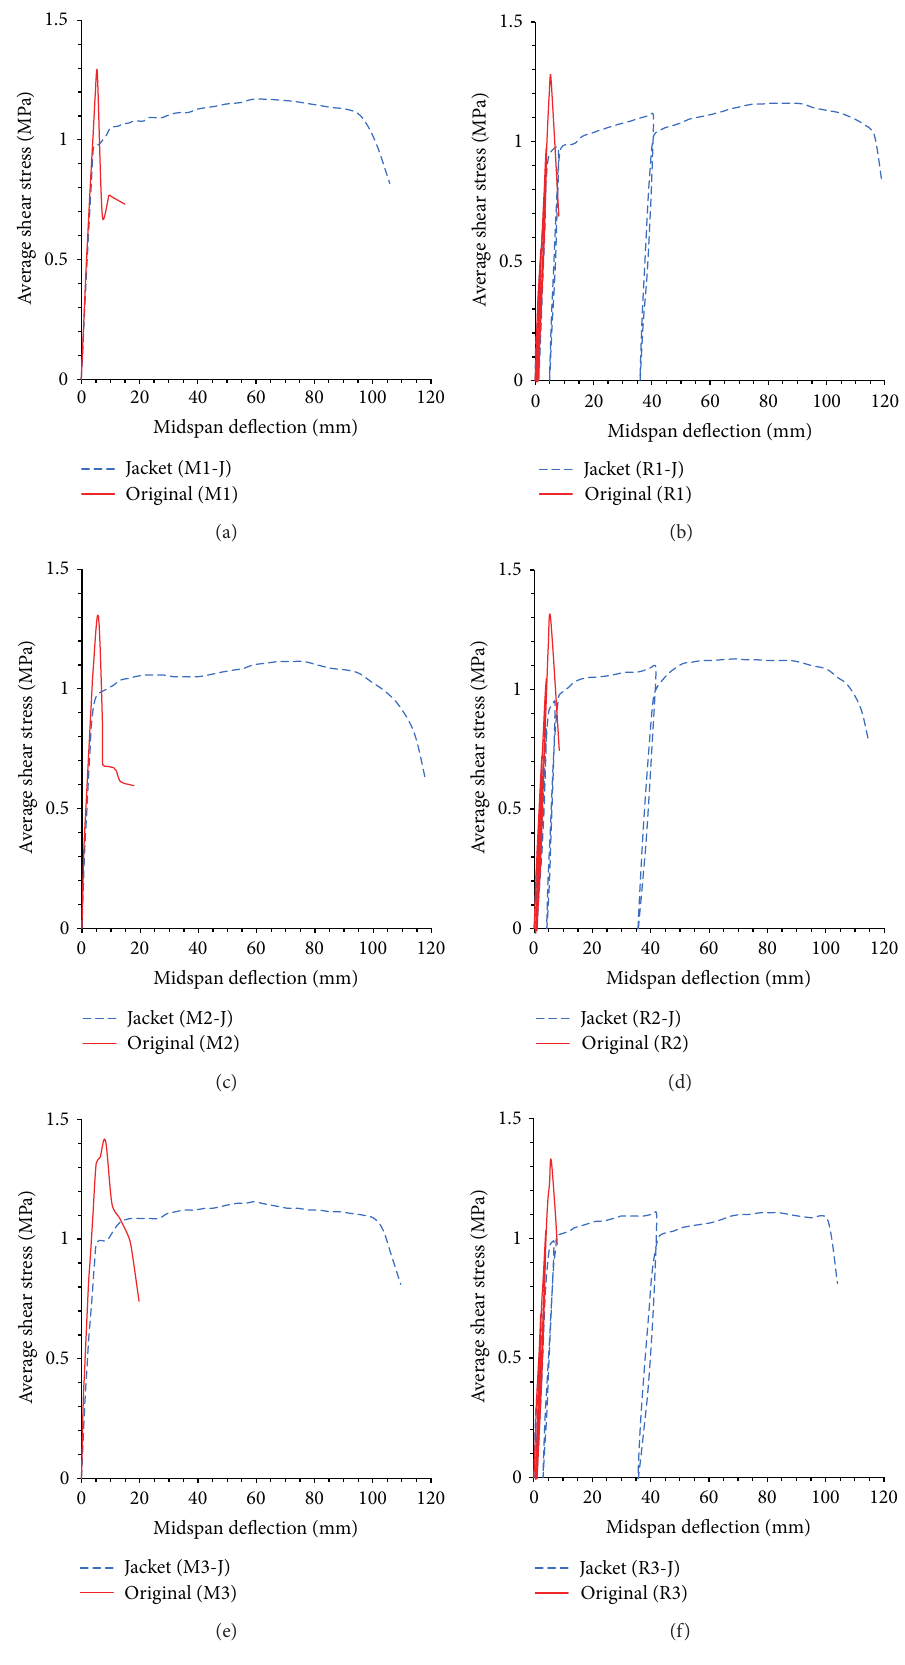
F 6: E��eri�en�al be�a�iour of ��e �e��ed bea�� in �er�� of a�erage ��ear ��re�� �er�u� �id��an